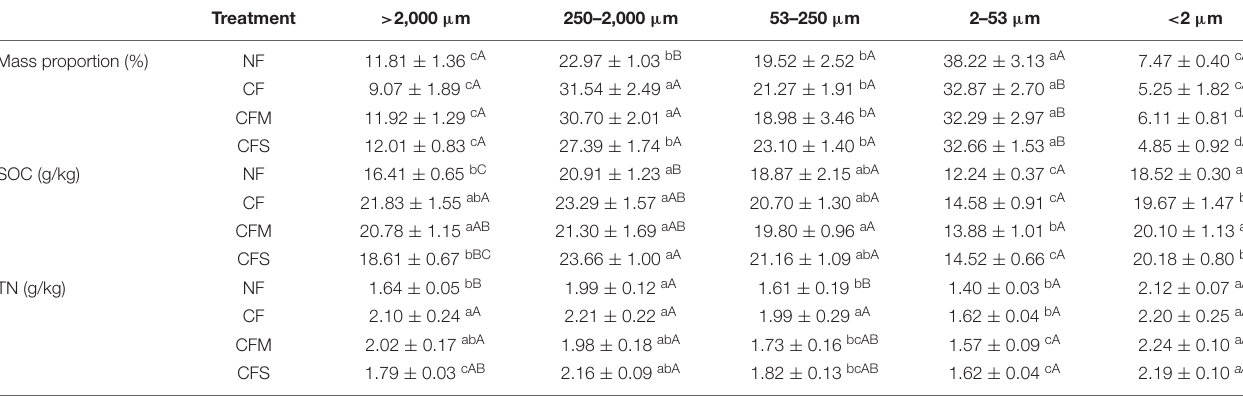
TABLE 2 | Mass proportion and basic properties (mean ± SD, n = 3) of aggregate-size fractions under different fertilization